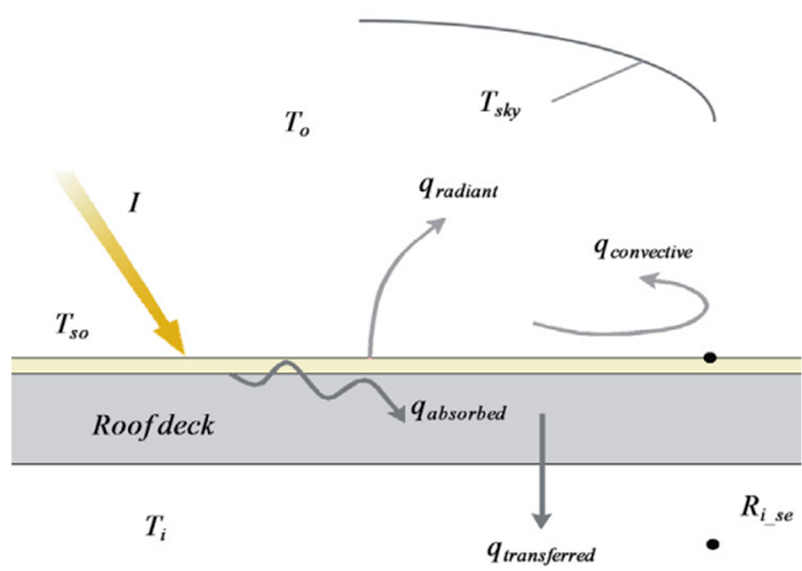
Figure 1. Energy balance for a cool or standard roof [15] (Gagliano et al., 2015).